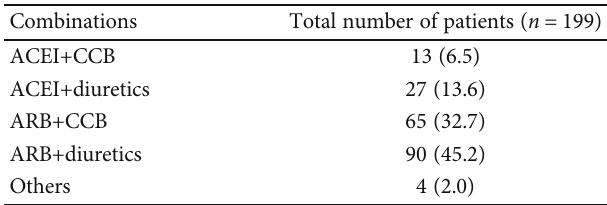
Table 2: Drug treatment in the study